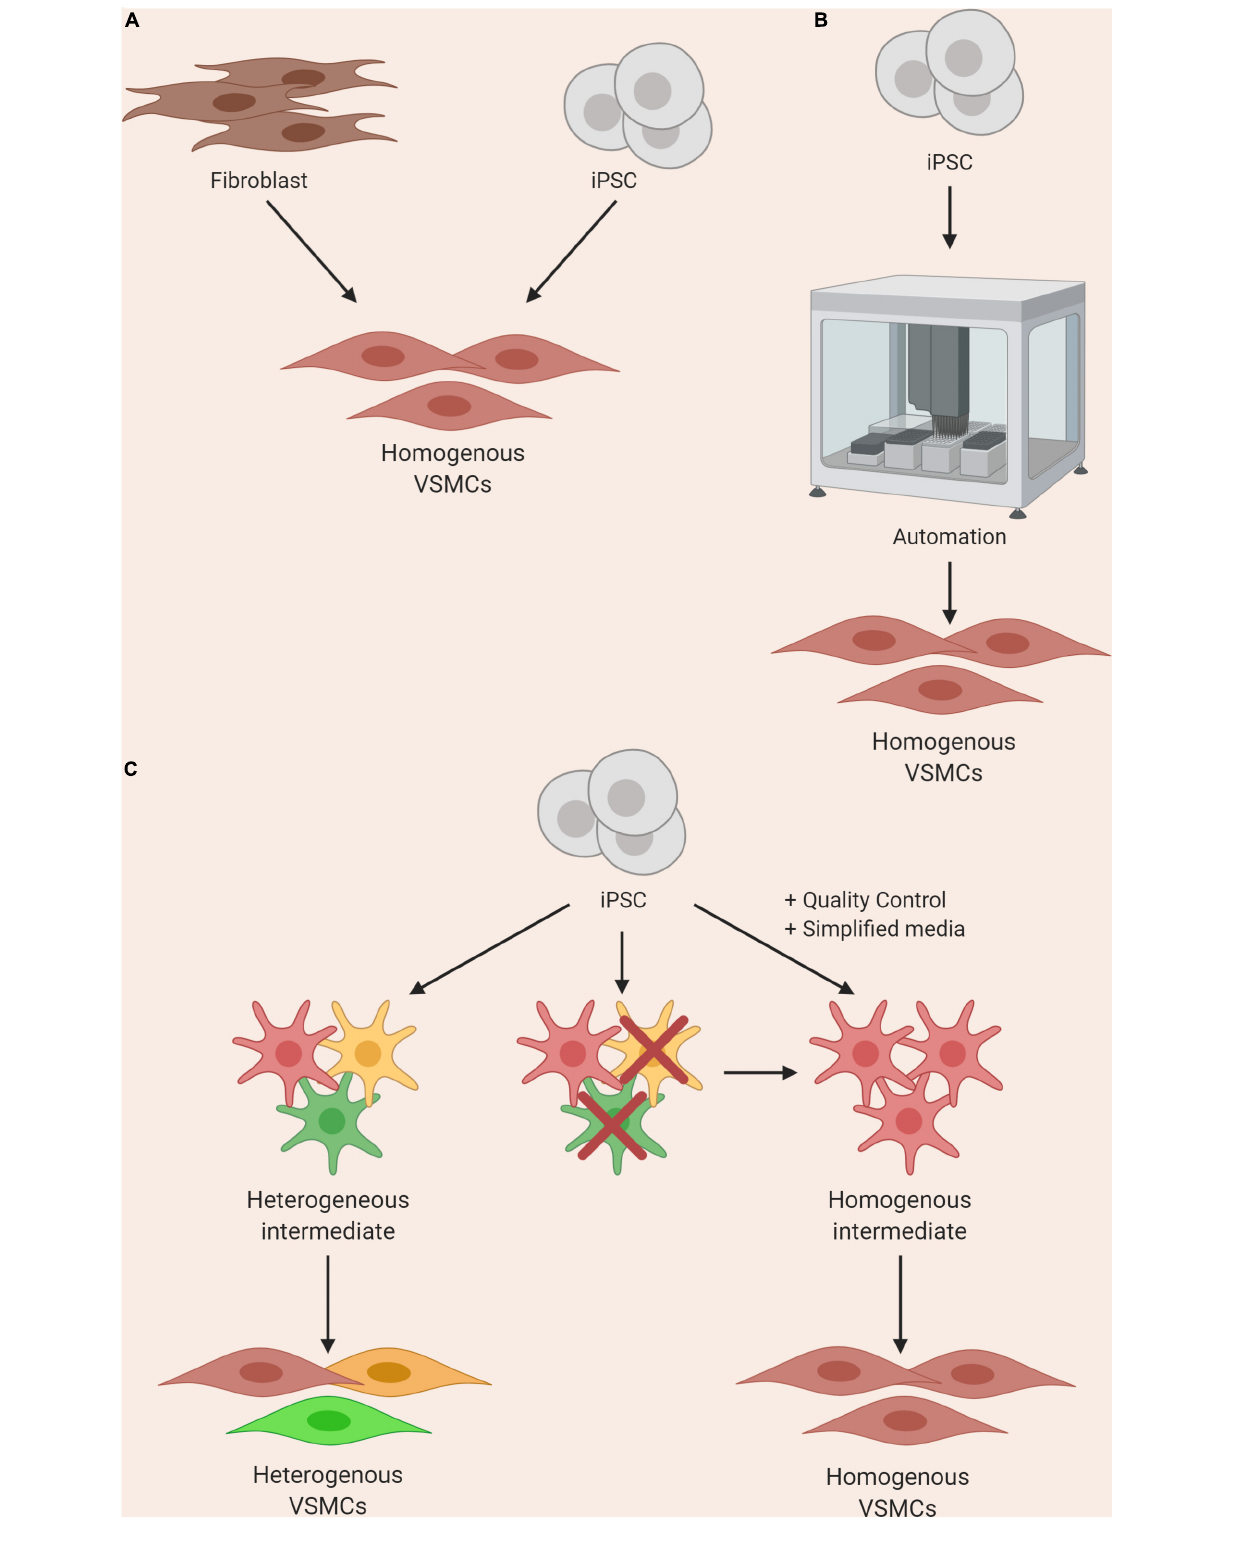
Frontiers in Cell and Developmental Biology |